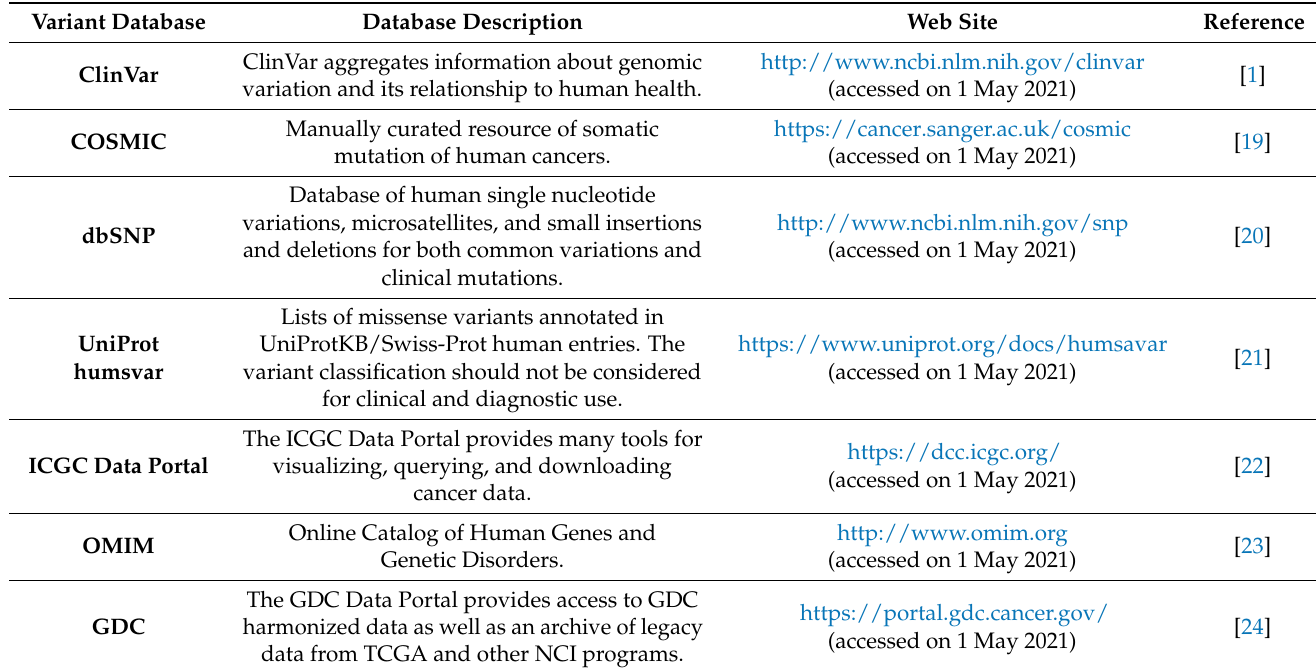
Table 1. Selected list of the databases of single nucleotide